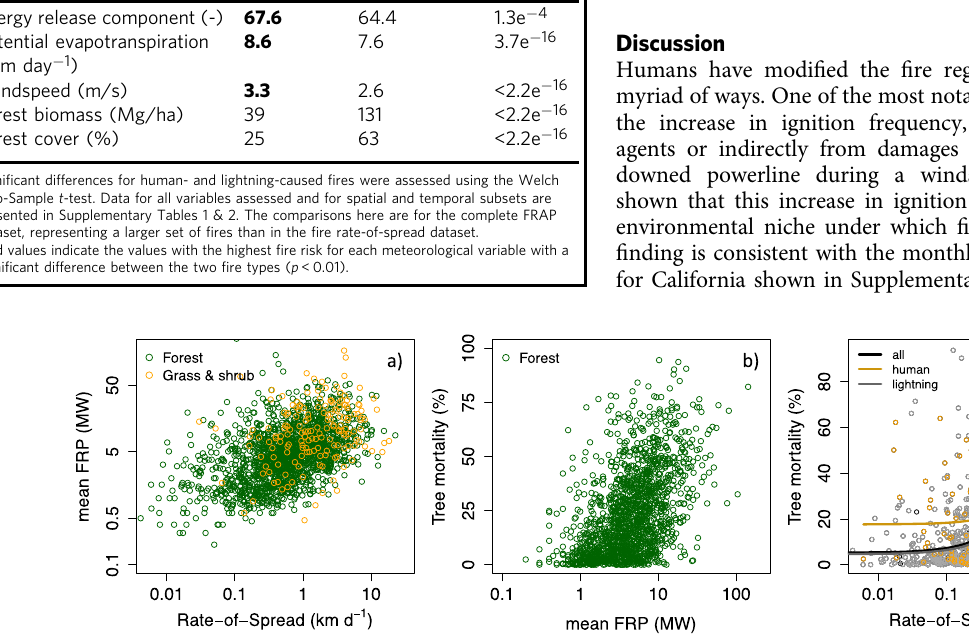
Fig. 3 The cascade from fi re behavior to fi re intensity and tree mortality. a Relationship between daily fi re radiative power (FRP; mean along fi re line) as a function of daily fi re rate-of-spread ( F -test, F -statistic = 504.6, N = 1722, R 2 = 0.23, p < 2.2e − 16 ). b Relationship between mean FRP and tree mortality (% reduction in basal area) ( F -test, F -statistic = 511.3, N = 1556, R 2 = 0.25, p < 2.2e − 16 ). c Relationship between tree mortality (% reduction in basal area) and daily fi re rate-of-spread ( F -test, F -statistic = 563.5, N = 1556, R 2 = 0.27, p < 2.2e − 16 ). The running means in panel c are plotted for all fi res (black line) and separately for human-caused fi res (orange line) and lightning-caused fi res (gray line). Plots for other fi re severity indicators are presented in Supplementary Fig. 9. Panels b and c include data across Californian forests for each fi re day where the fi re expanded more than 1 ha. Linear regression was used to estimate R 2 and p -values. Fire rate-of-spread is calculated as the 95th percentile spread rates along the full active fi re perimeter fi re on that day. The apparent difference at low rate-of-spreads between human-caused and lightning-caused fi res in panel c is likely statistically insigni fi cant given the low density and high scatter of available data under these